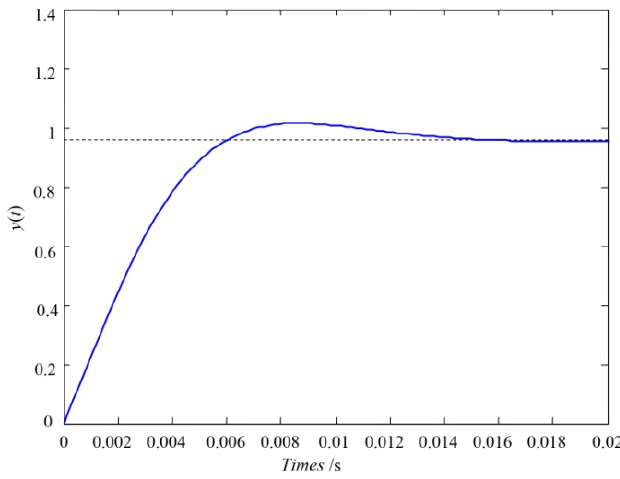
Figure 7. Step response curve of system after adding self-tuning PID control.